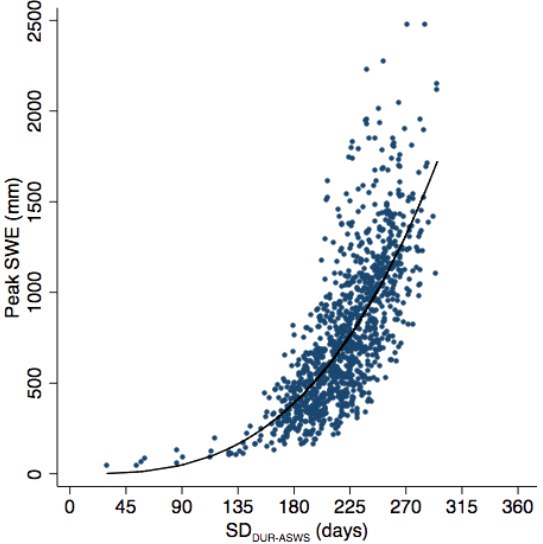
Figure 6. Scatterplot of SD DUR-ASWS and the corresponding peak snow water equivalent (SWE) for all automatic snow weather sta- tions (ASWSs) with valid data for a given year. The general rela- tionship between SD DUR-ASWS and peak SWE appears to be non- linear and is described best by a power function.